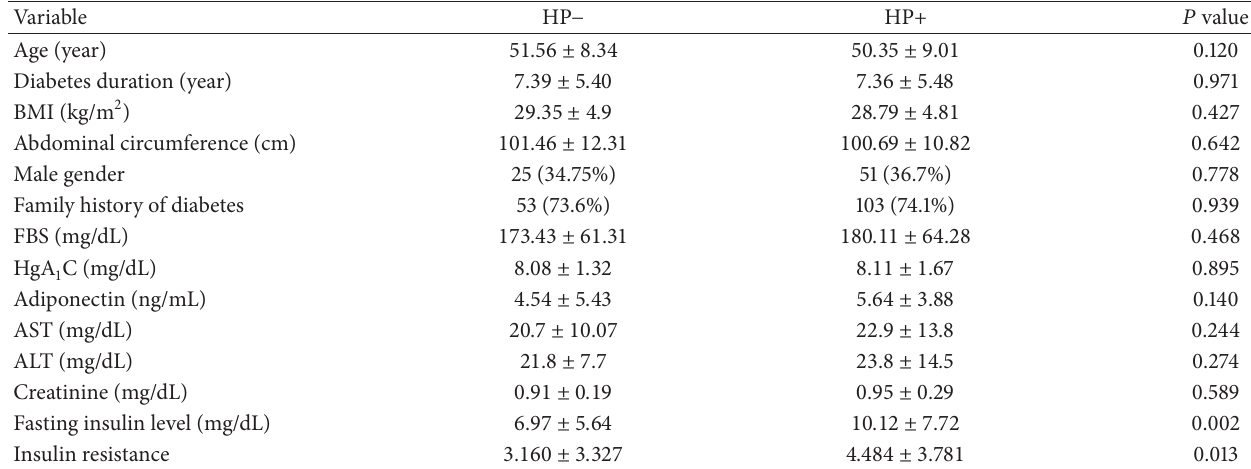
Table 1: Characteristics and biochemical markers of the patients.